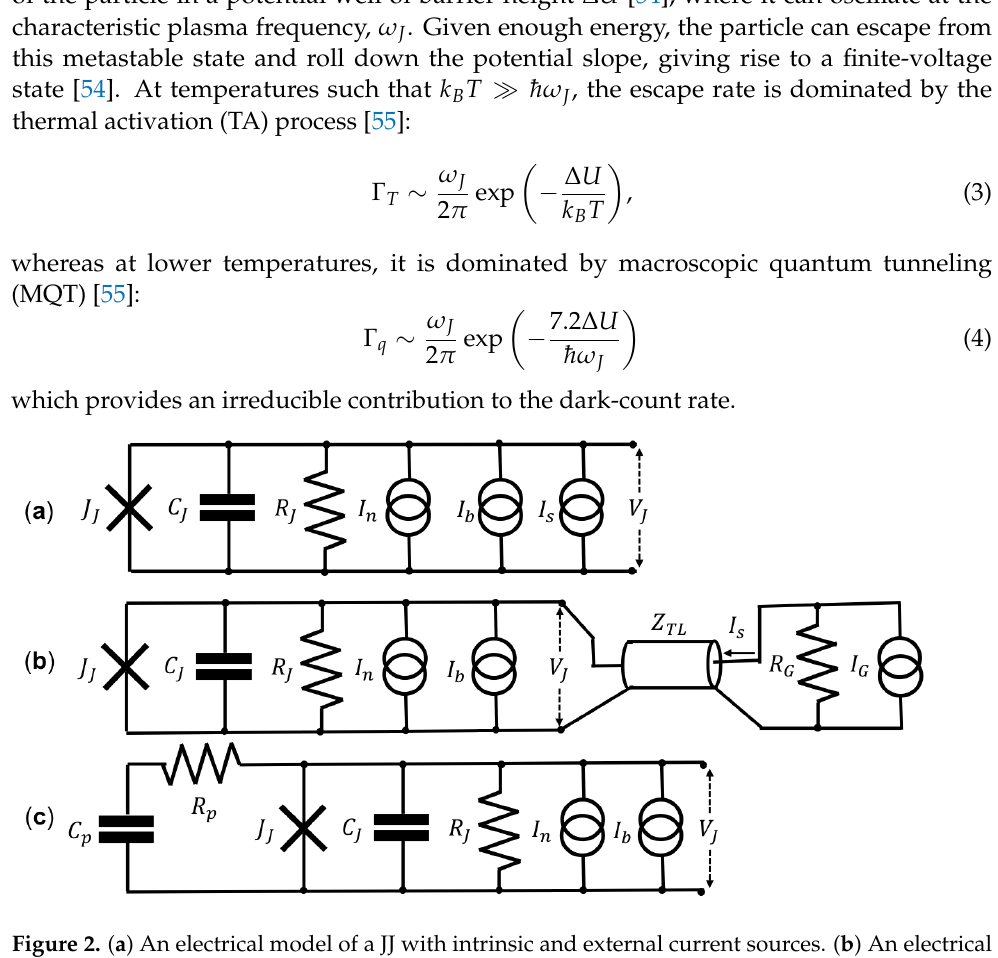
Figure 2. ( a ) An electrical model of a JJ with intrinsic and external current sources. ( b ) An electrical